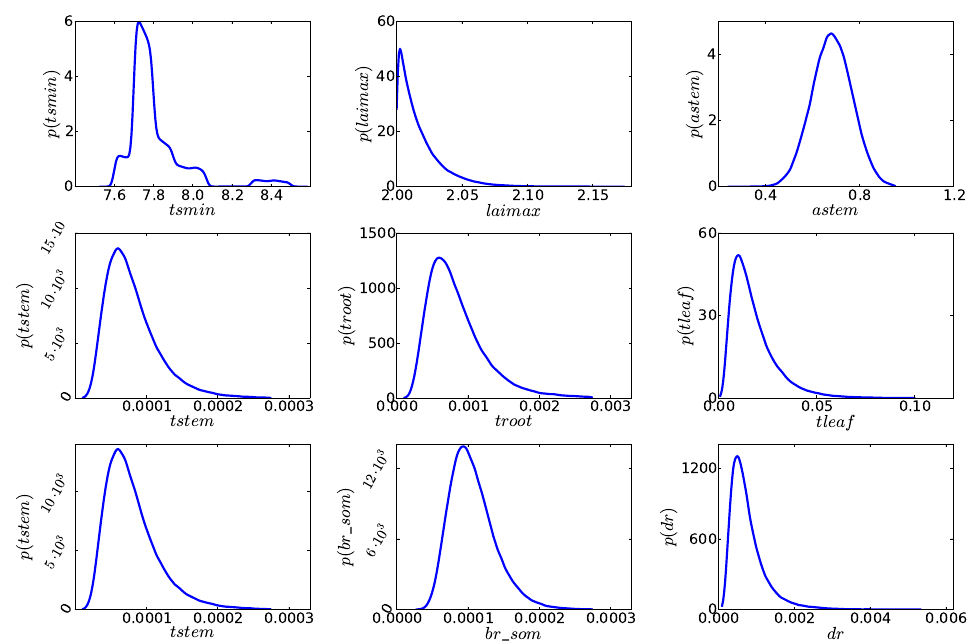
Figure 14. D ST problem: 1-D marginal PDFs for parameters showing distance correlation factors less than 0.4 with other parameters; see also Table 3. Marginal PDFs are estimated via KDE based on approximately 4 × 10 5 MCMC